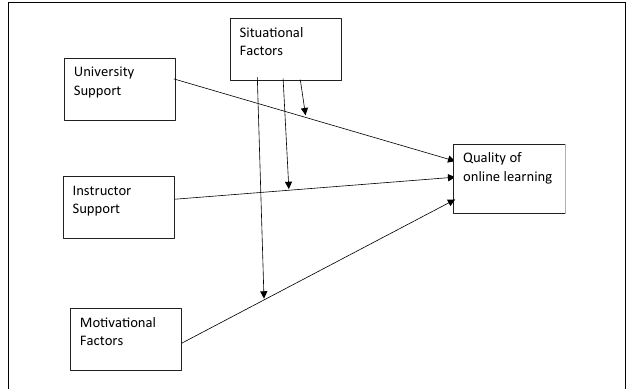
FIGURE 1 | Proposed model for factors affecting the quality of online